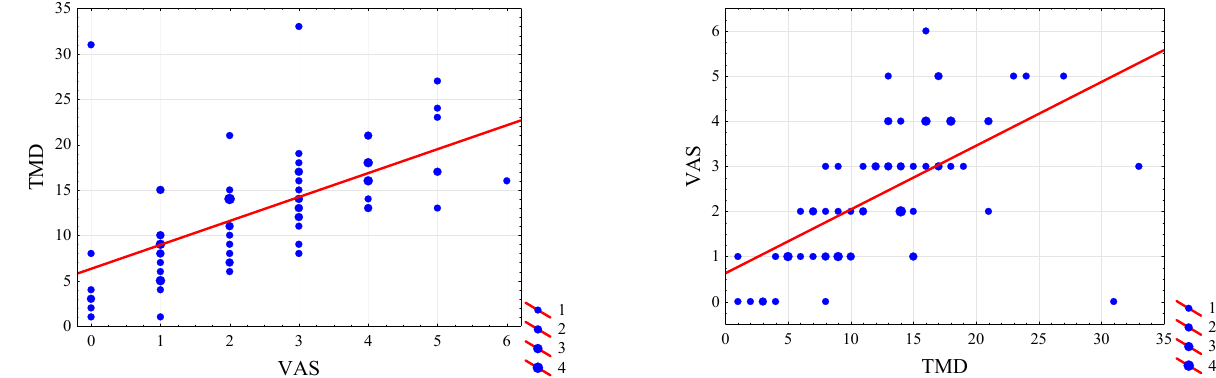
Figure 3. Differences in values of the level of perceived pain between enrolled participants: ( a ) Total dose of morphine consumed by patients with a different type of intervention and the result of the analysis of variance and multiple compar- isons (Tukey’s post hoc tests); ( b ) Pain sensation assessed on the VAS scale at discharge by patients differing in the type of intervention and the result of the analysis of variance and multiple comparisons (Tukey’s post hoc tests); ( c ) Expected boundary values of the perceived pain (mean and their 95% confidence intervals) and the assessment of the impact of treatment; p < 0.00001; ( d ) Expected boundary values of the perceived pain (mean and their 95% confidence intervals) and time after the surgery; p = 0.028. TG—true group; CG—control group; SG—sham group; VAS—visual analog scale; TMD—